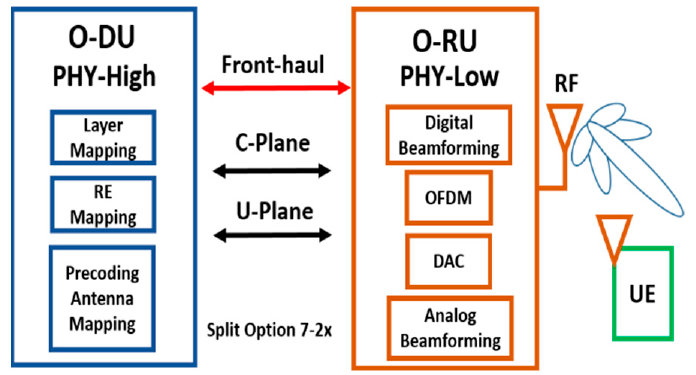
Figure 2. O-RAN Hybrid beamforming block diagram.